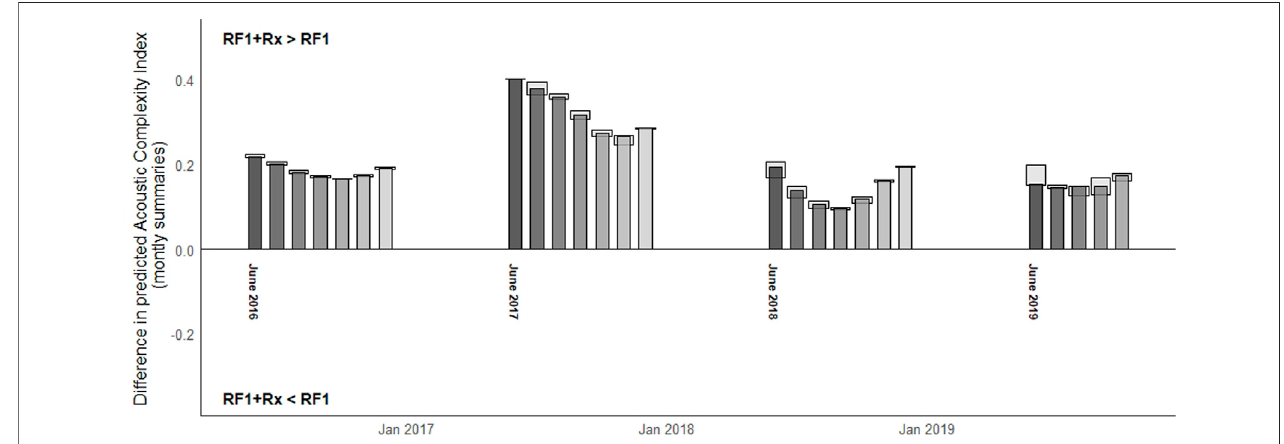
FIGURE 4 | Difference in predicted Acoustic Complexity Index between sites burned by the Rough Fire with prior prescribed burn (RF1 + Rx) compared to sites without prior prescribed burn (RF1). Positive values indicated ACI or ecoacoustic activity was higher at sites with prescribed burn prior to Rough Fire. Gray shaded bars are median differences for the speci fi c month, colored by month. Light gray bars behind are the 75th and 25th quartiles for the monthly differences.